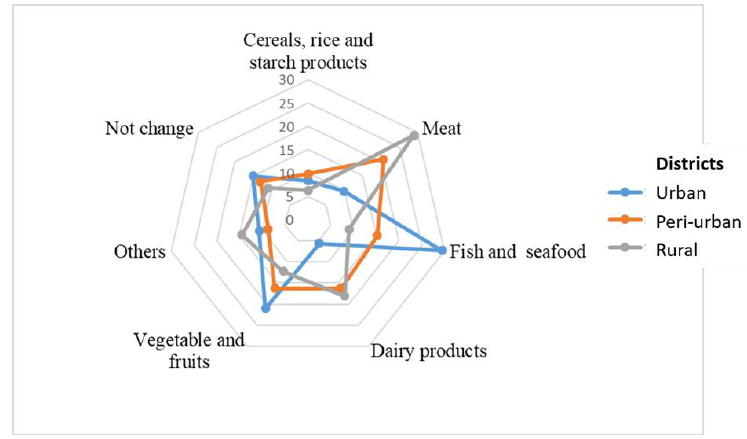
Figure 7. Food groups that households would prefer to buy more of if their food expenditure budget were to increase (%).